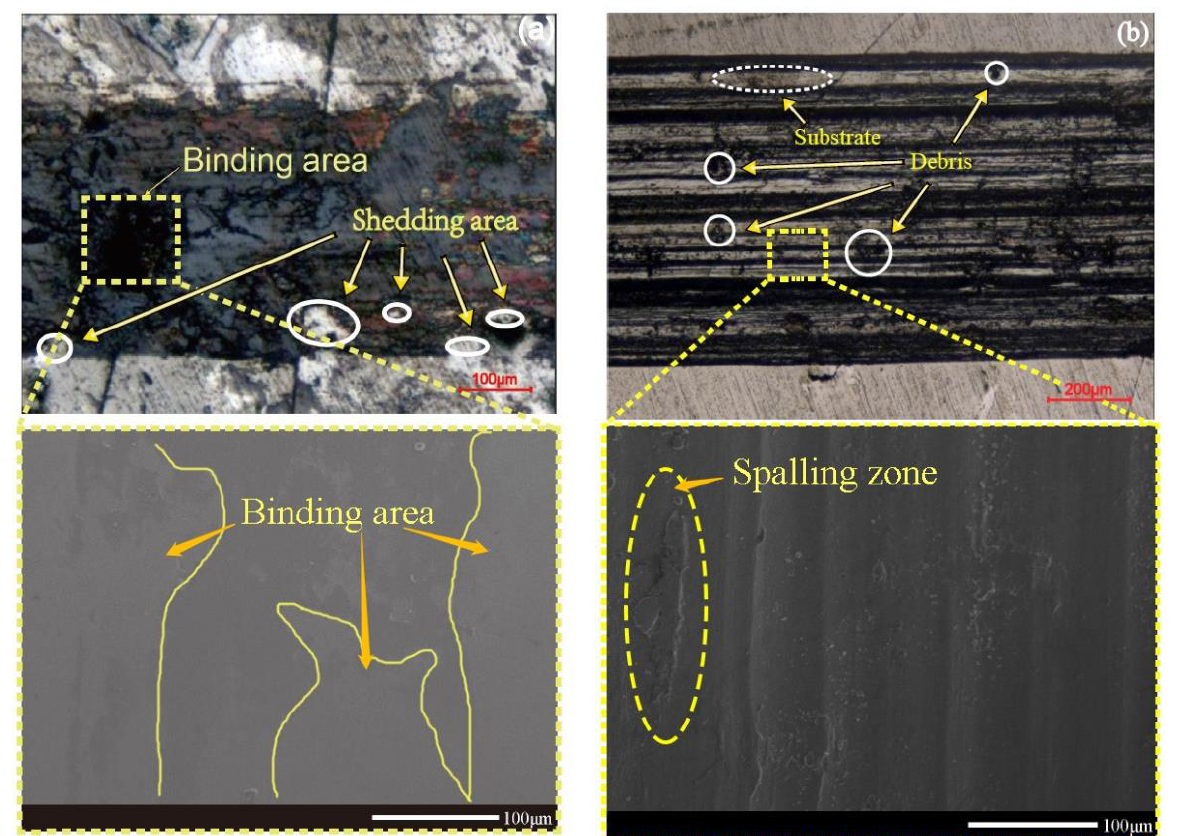
Figure 7. ( a ) A wear mark of amorphous powder cladding layer; ( b ) A wear mark of crystalline powder cladding layer.